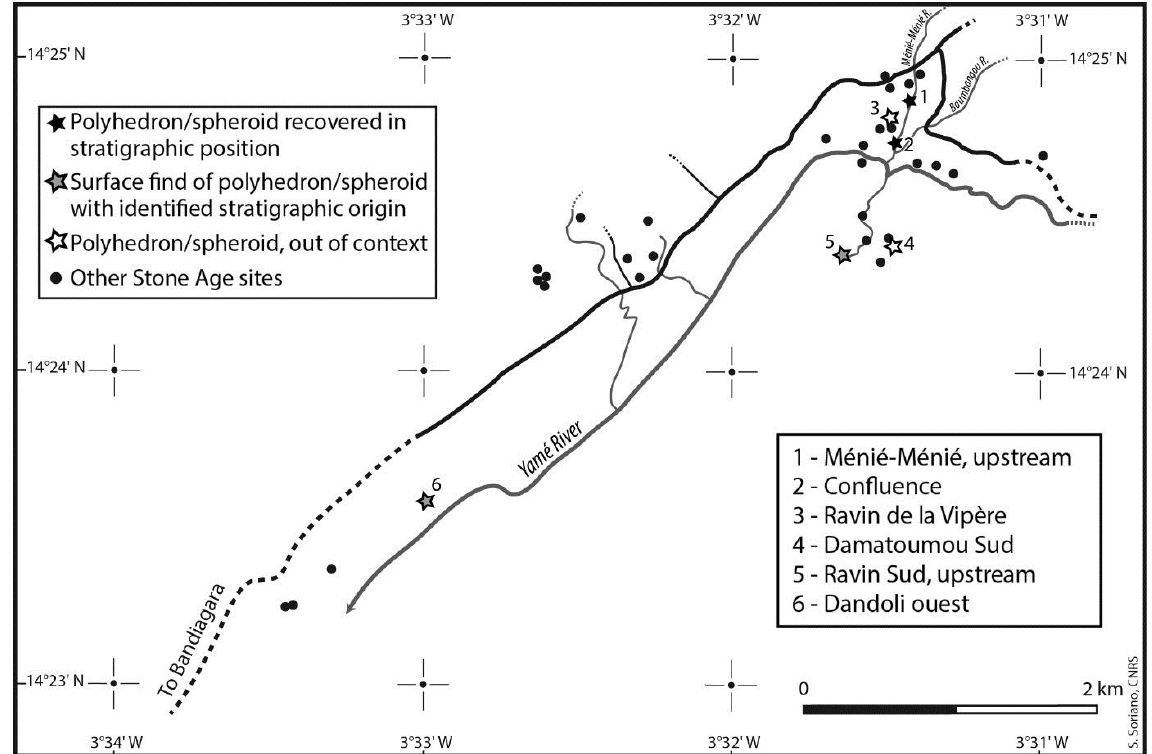
Figure 6. Location of all Paleolithic sites of Ounjougou complex (Courtesy of Sylvain Soriano, Mission archéologique